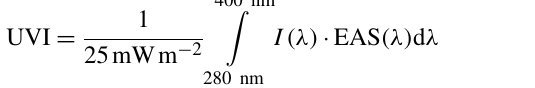
Figure 2. The UV Index is defined as the integral of the erythemally weighted irradiance spectrum (shaded region), produced from the product of the surface irradiance (red curve; see Fig. 1) and the ery- themal action spectrum (green curve), over the UV-A and UV-B spectral ranges. The result is then multiplied by a scaling factor (25mWm − 2 ) -1 to create a numerically convenient value for the in- dex. Also depicted are the corresponding irradiances for the GEM broadbands divided by their respective